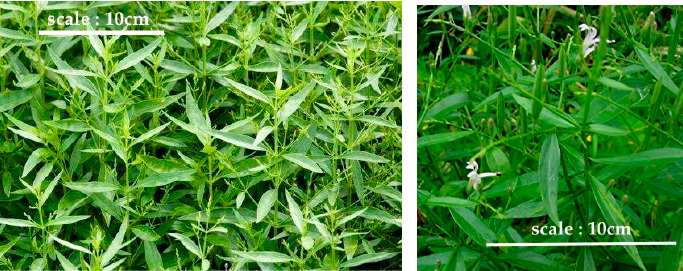
Figure 1. Andrographis paniculata.